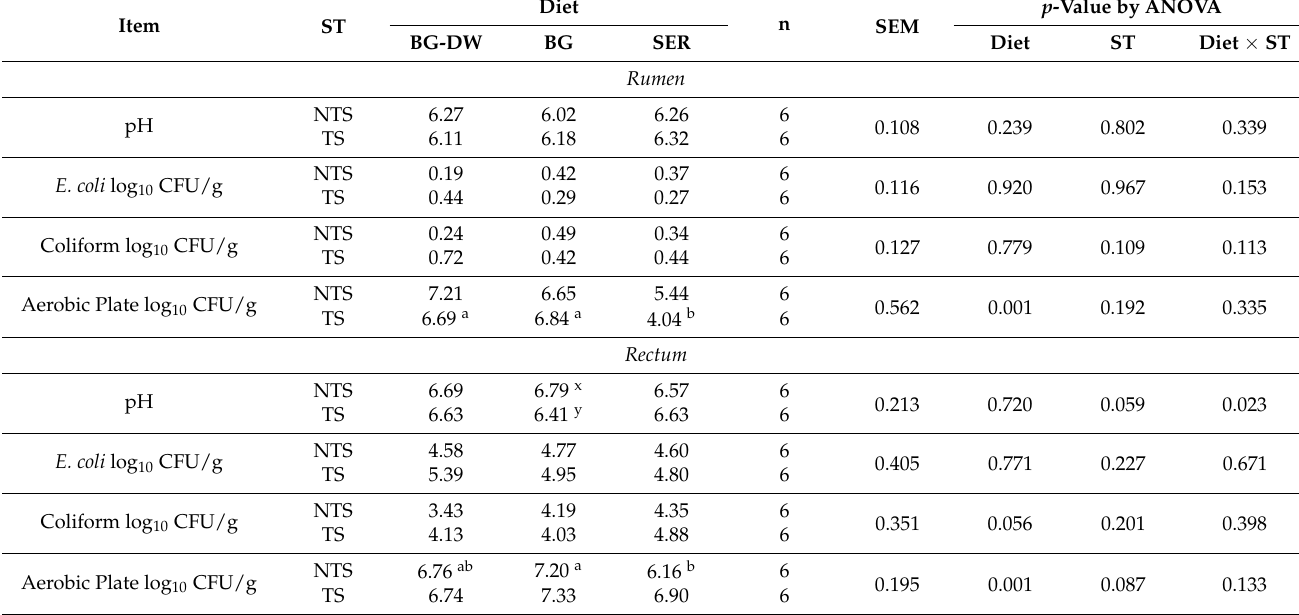
Table 4. Effects of diet (BG-DW: bermudagrass hay—dewormed; BG: bermudagrass hay; SER: sericea hay) and stress treatment (ST: Non-Transported, NTS; Transported, TS) on pH and microbial counts in the rumen and rectum of